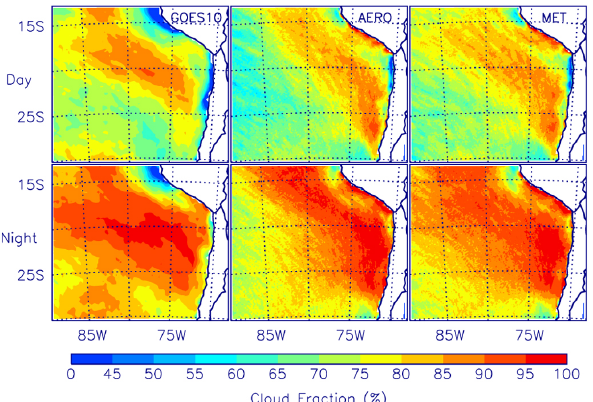
Fig. 8. Mean low cloud fractions during day and night for the VOCALS-REx period retrieved from the GOES–10 (left), and those from the AERO (middle) and MET (right) model